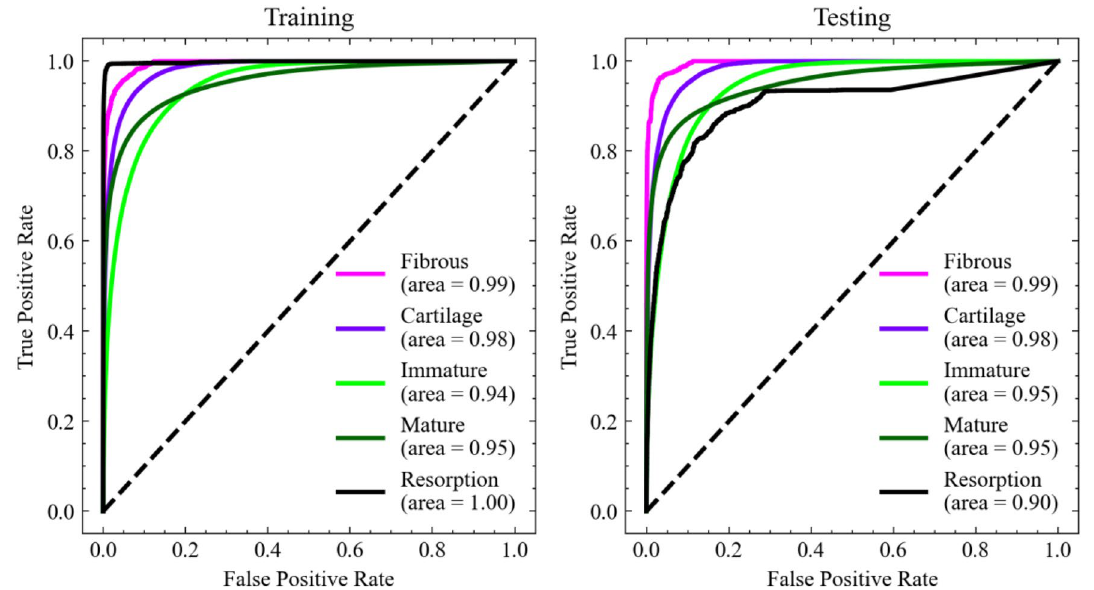
Figure 4. ROC curves for the classification of each tissue